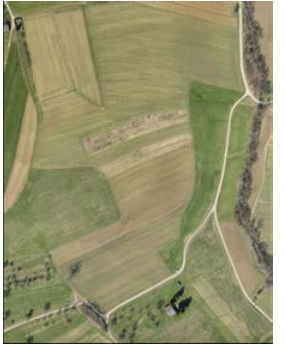
Figure 3: Flight BezF1 area.